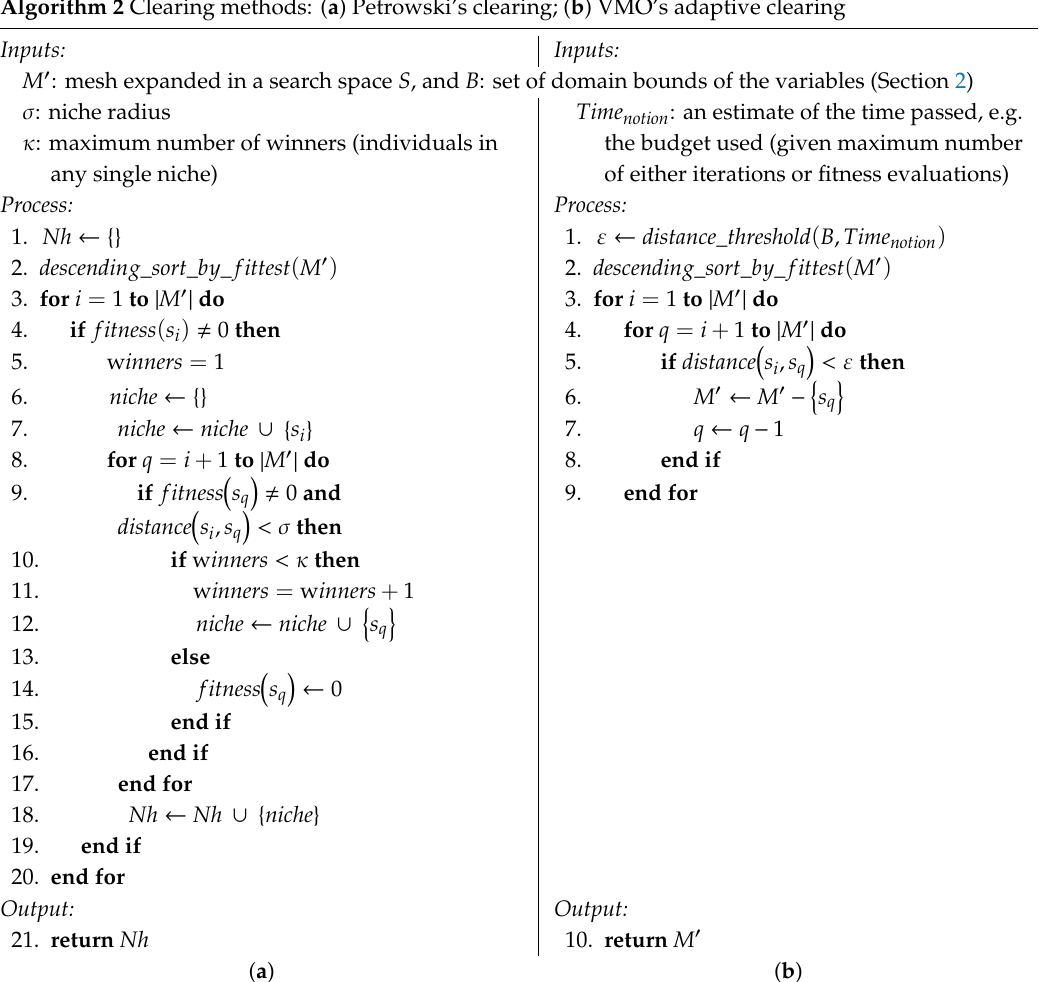
Algorithm 2 Clearing methods: ( a ) Petrowski’s clearing; ( b ) VMO’s adaptive